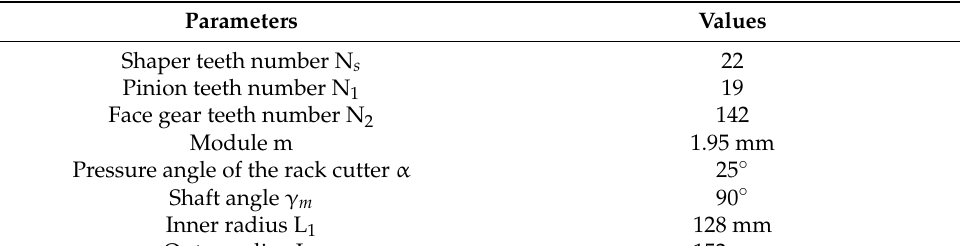
Table 2. The parameters of a face gear.